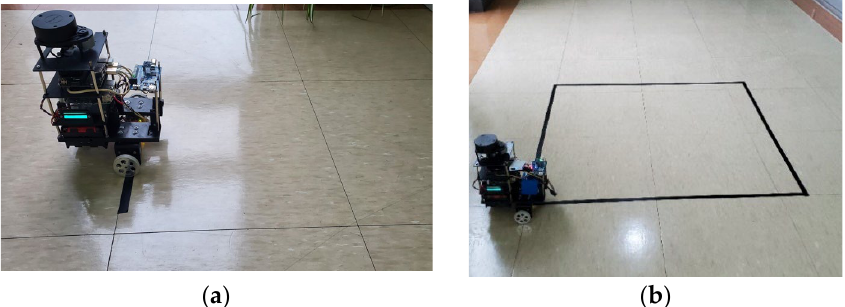
Figure 9. Testing scenarios. ( a ) Teleoperation movement test; ( b ) Odometer test for square line patrol.